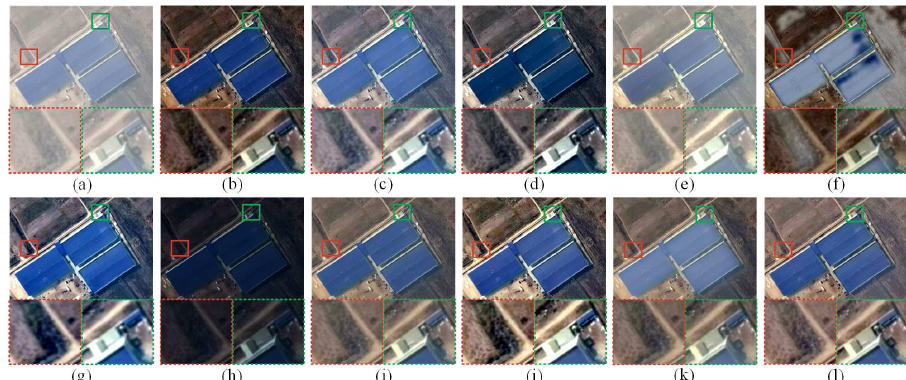
Figure 7. Dehazing example 1 of a remote sensing image from a real hazy scene: ( a ) Original; ( b ) DCP; ( c ) GPR; ( d ) AMP; ( e ) DEFADE; ( f ) WCD; ( g ) RRO; ( h ) MOF; ( i ) CAP; ( j ) HLM; ( k ) DN; ( l ) Proposed. Two partially enlarged images marked in red and green dotted frames correspond to the regions surrounded by red and green frames in the dehazed image.